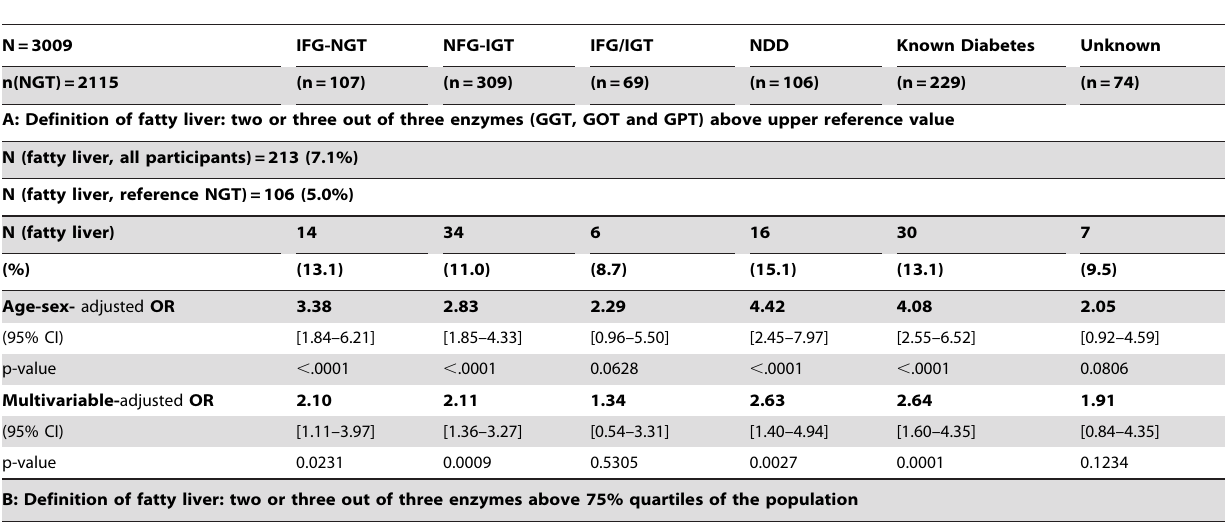
Table 3. Association of fatty liver with glucose tolerance subgroups: Normal glucose tolerance was used as reference, fatty liver was defined in three different ways (A–C) as specified in the